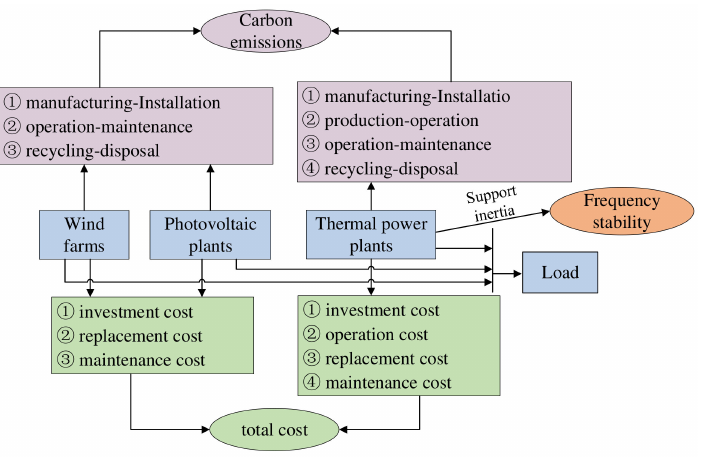
Figure 1. Wind-photovoltaic-thermal power system characteristics.